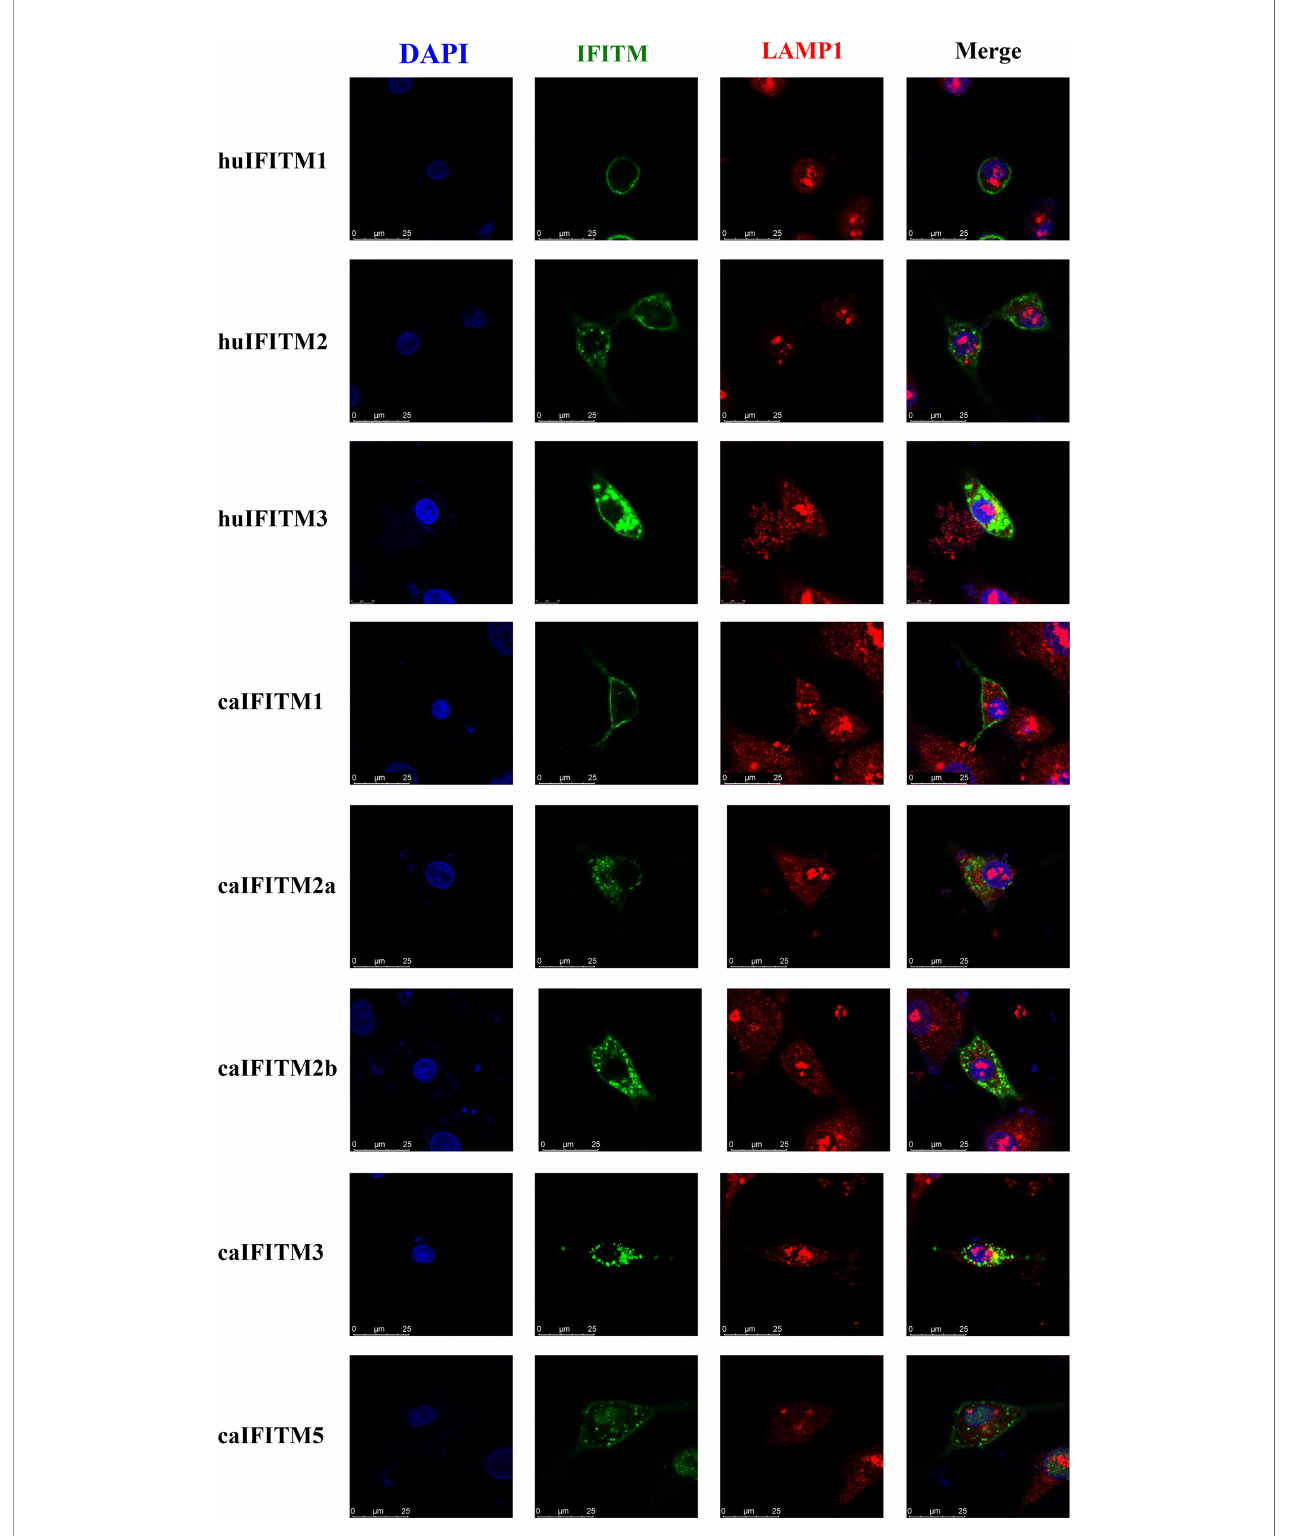
FIGURE 5 | Subcellular localization of caIFITMs. A549 cells were transfected with Flag-tagged IFITM expression construct. After 24 h, the cells were stained with an anti-FLAG antibody (green) and an anti-LAMP1 antibody (red), and nucleus were stained with DAPI (blue). Finally, the cells were analyzed by a confocal microscopy.